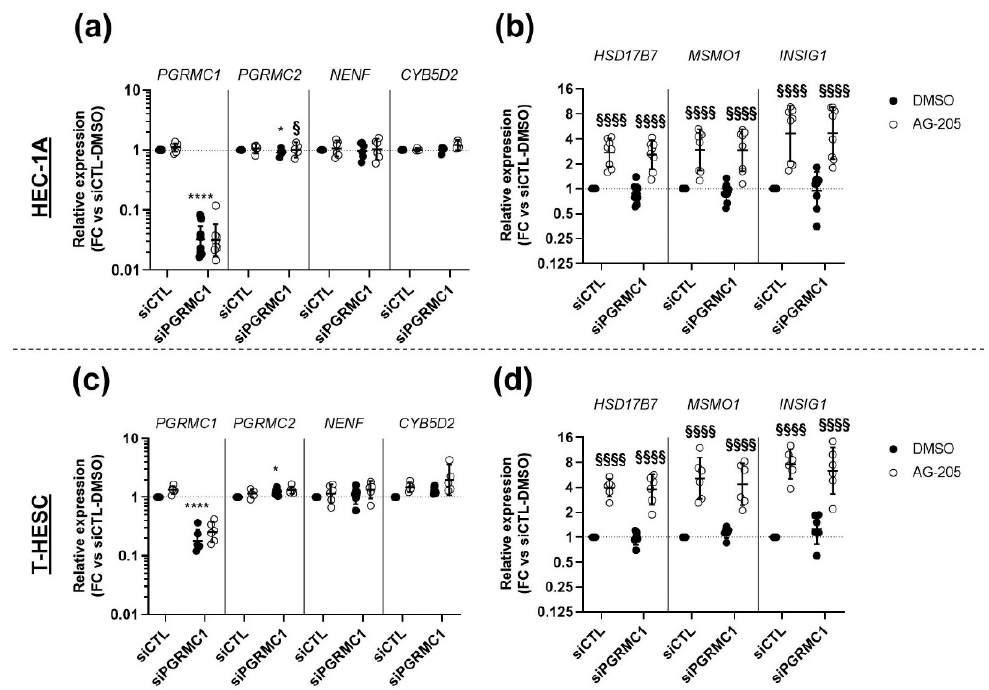
Figure 6. Effect of AG-205 on expression of selected target genes is not modified upon combined siRNA-mediated down-regulation of PGRMC1 . HEC-1A ( a , b ) or T-HESC cells ( c , d ) were transfected with 10nM siRNA-PGRMC1 s21310 (siPGRMC1) or control siRNA-CTL (siCTL) during 48 h and then further incubated for 32 h with 15 µ M AG-205 or DMSO. Relative expression of PGRMC1, PGRMC2, NENF and CYB5D2 ( a , c ) and HSD17B7, MSMO1 and INSIG1 ( b , d ) was measured by RT-qPCR ( n = 6 – 8), normalized, compared to dual control values (siCTL with DMSO) and is presented as individual fold changes (FC) in log or log2 scale and as geometric means with geometric SD. Statistical test: Anova-two ways with post-hoc Tukey. Statistically significant differences resulting from siPGRMC1 transfection or AG205 addition are indicated by * or §, respectively: */§ p < 0.05, ****/§§§§ p < 0.0001.